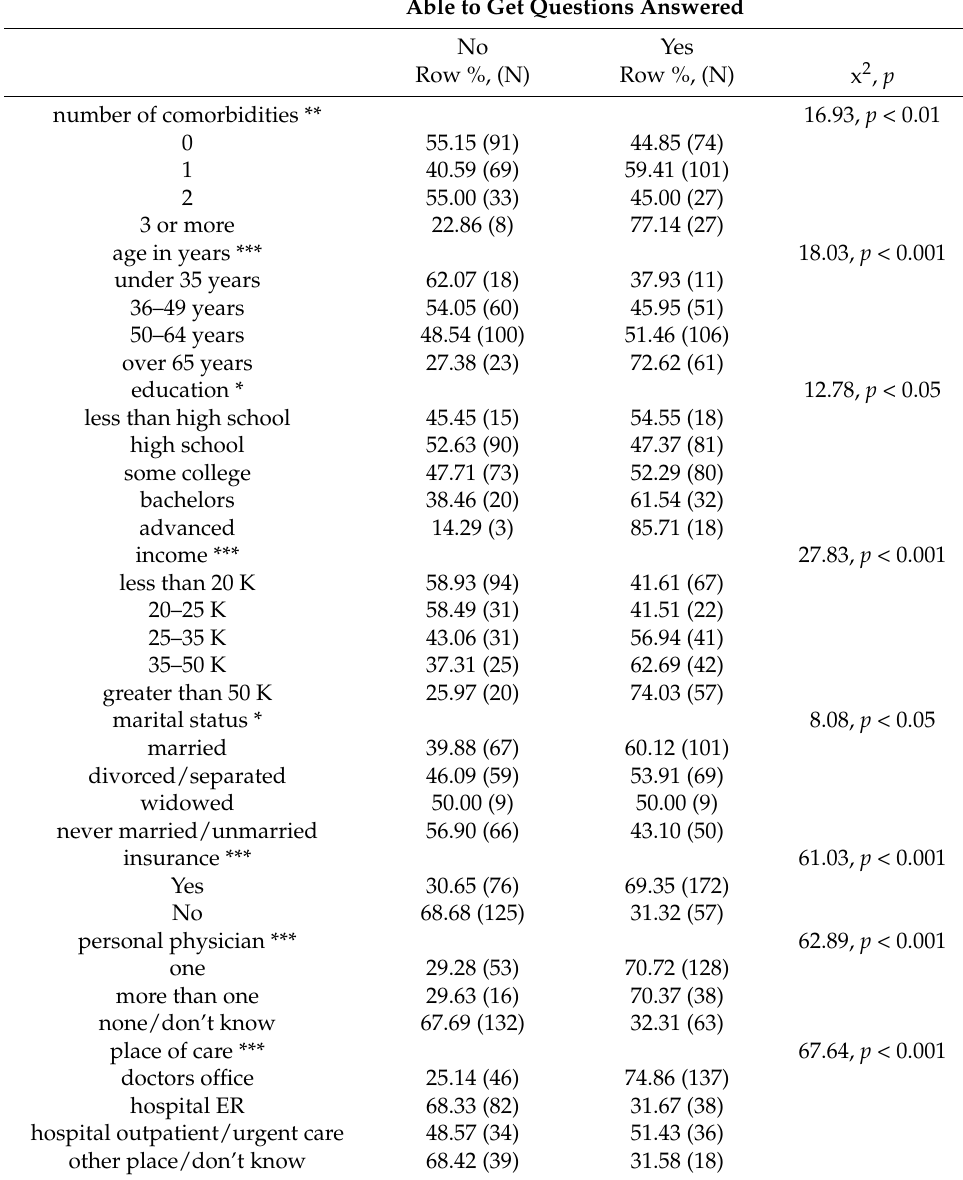
Table 2. Bivariate tests of association [Chi Square] between having questions answered and covariates of interest, MHHS,